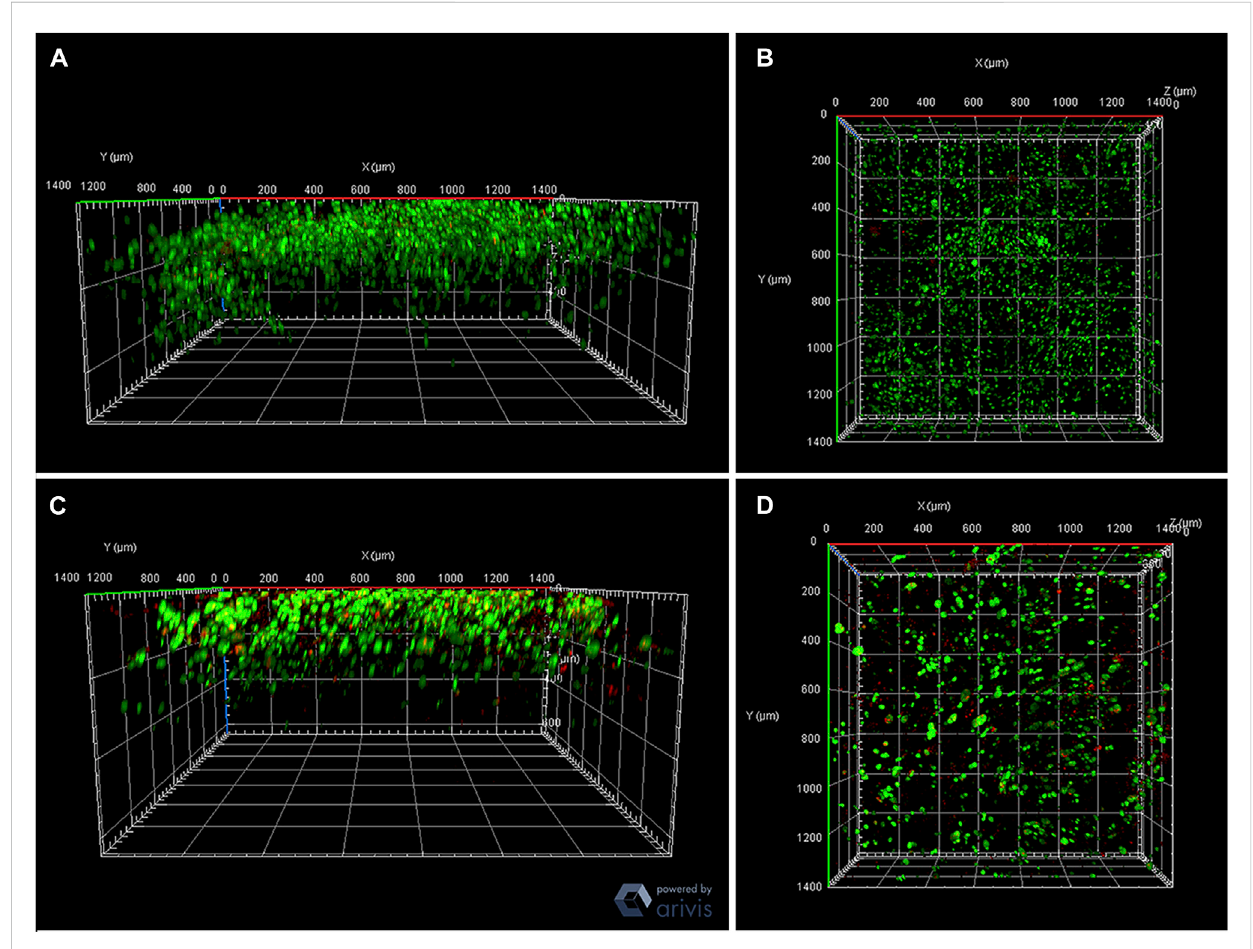
FIGURE 13 Analysisofextrusionin fl uenceonbioprintedconstructcontainscells.Bioprintedconstructsemployingalginate4%andgelatin3%onday0 (A,B) and in culture after 7 days (C,D) after the bioprinting process. Green: Calcein AM; Red: PI (Propidium iodide). View of Z stacks — AxioObserver Zeiss